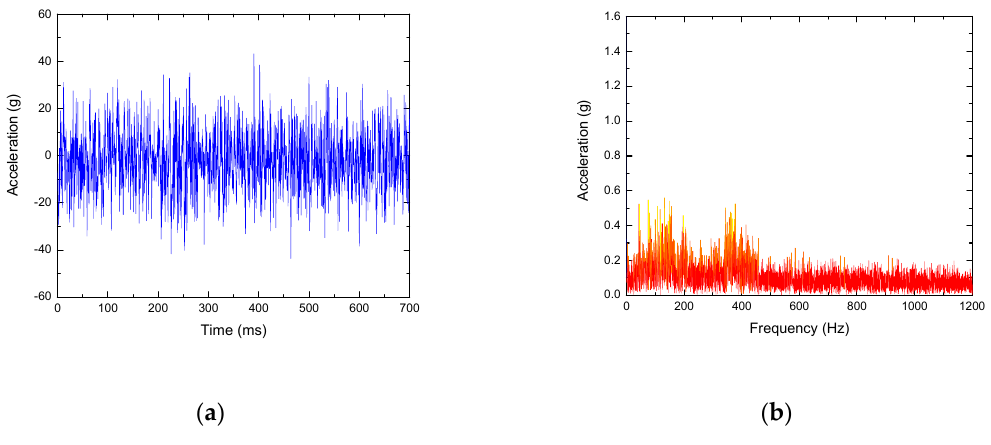
Figure 15. Analysis of a rail vibration signal with corrugation damage. ( a ) Waveform; ( b ) frequency spectrum.